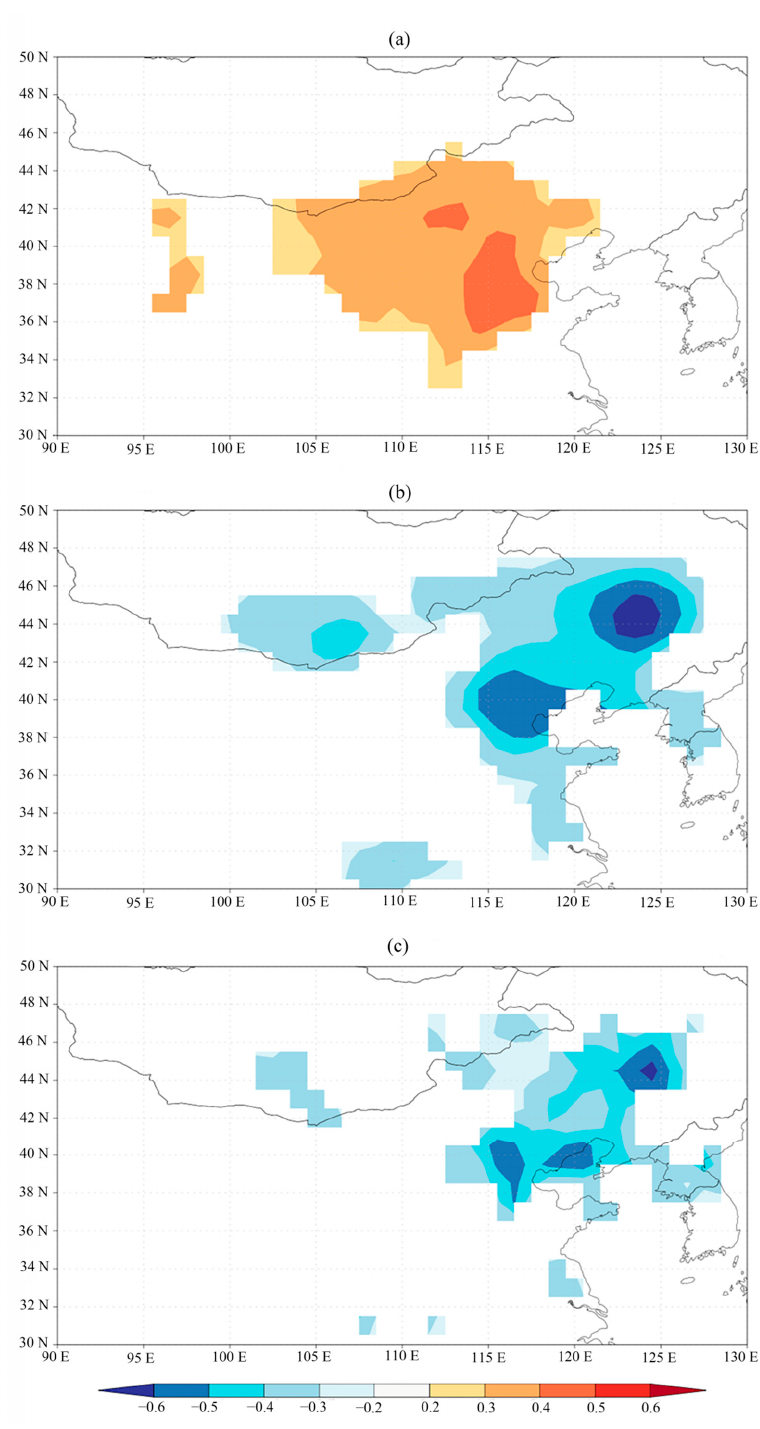
Figure 5. Spatial correlations patterns between first principal component (PC1) and ( a ) June–August averaged Climatic Research Unit (CRU) TS 4.03 maximum temperature (T max ) (1951–1994 CE) and ( b ) May–June averaged CRU TS 4.03 precipitation (1951–1994 CE) and ( c ) May–June averaged GPCC (Global Precipitation Climatology Centre) 1.0 precipitation (1951–1994 CE). Correlations not significant at the 90% level have been masked out on the